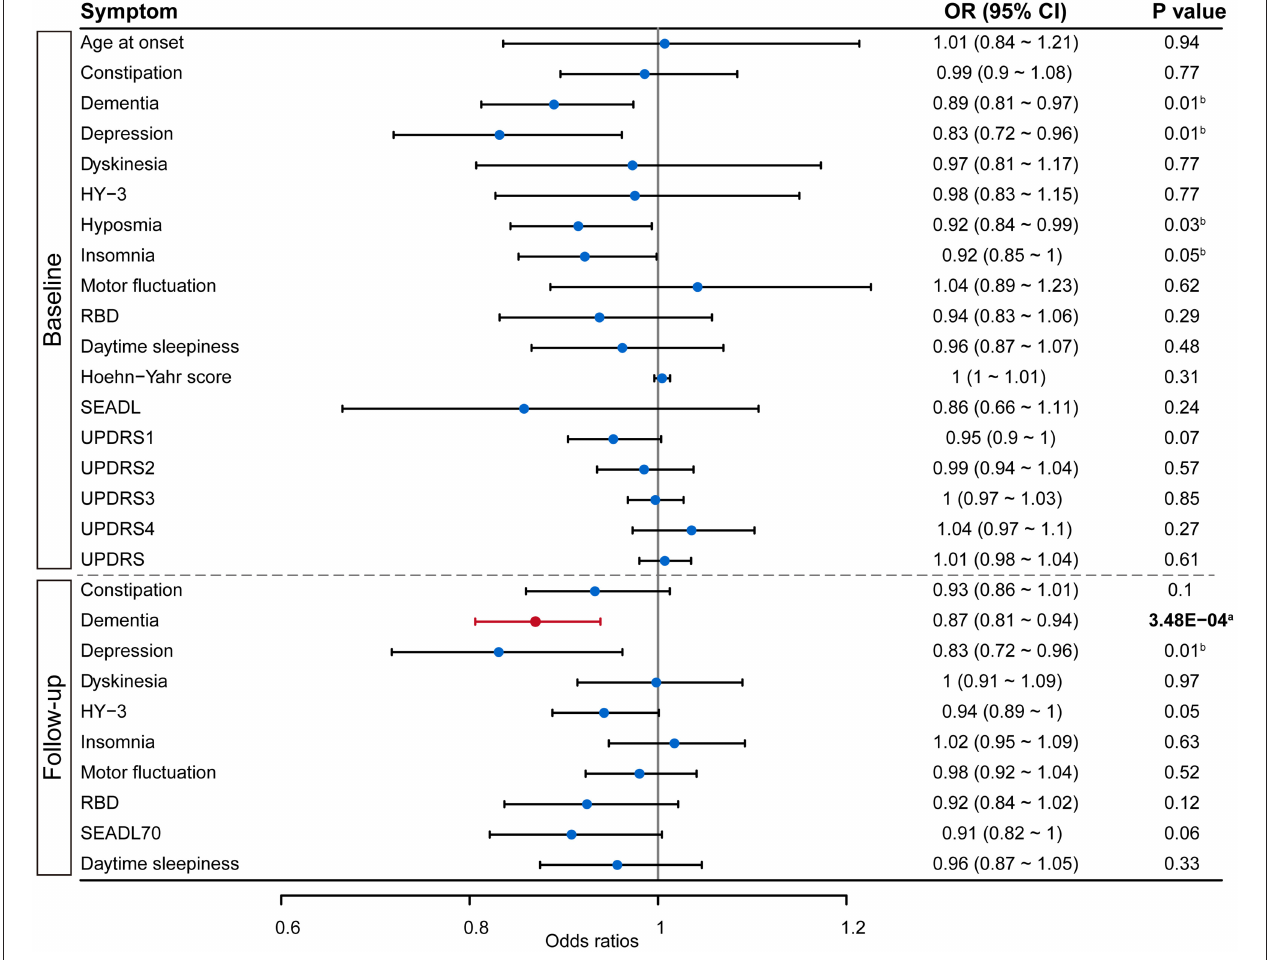
FIGURE 1 | Forest plot showing Mendelian randomization analysis results to evaluate the causal association between green tea intake and progression of PD. Results above the dashed line are for symptoms collected at baseline, while results below the dashed line are from survival analysis on symptom progression during follow-up. SEADL, Schwab and England Activities of Daily Living Scale; UPDRS, Unified Parkinson Disease Rating Scale; HY-3, Hoehn Yahr scale 3 or greater; RBD, REM sleep behavior disorder; SEADL70, SEADL of 70 or less. a Denotes statistical significance, while b denotes nominal